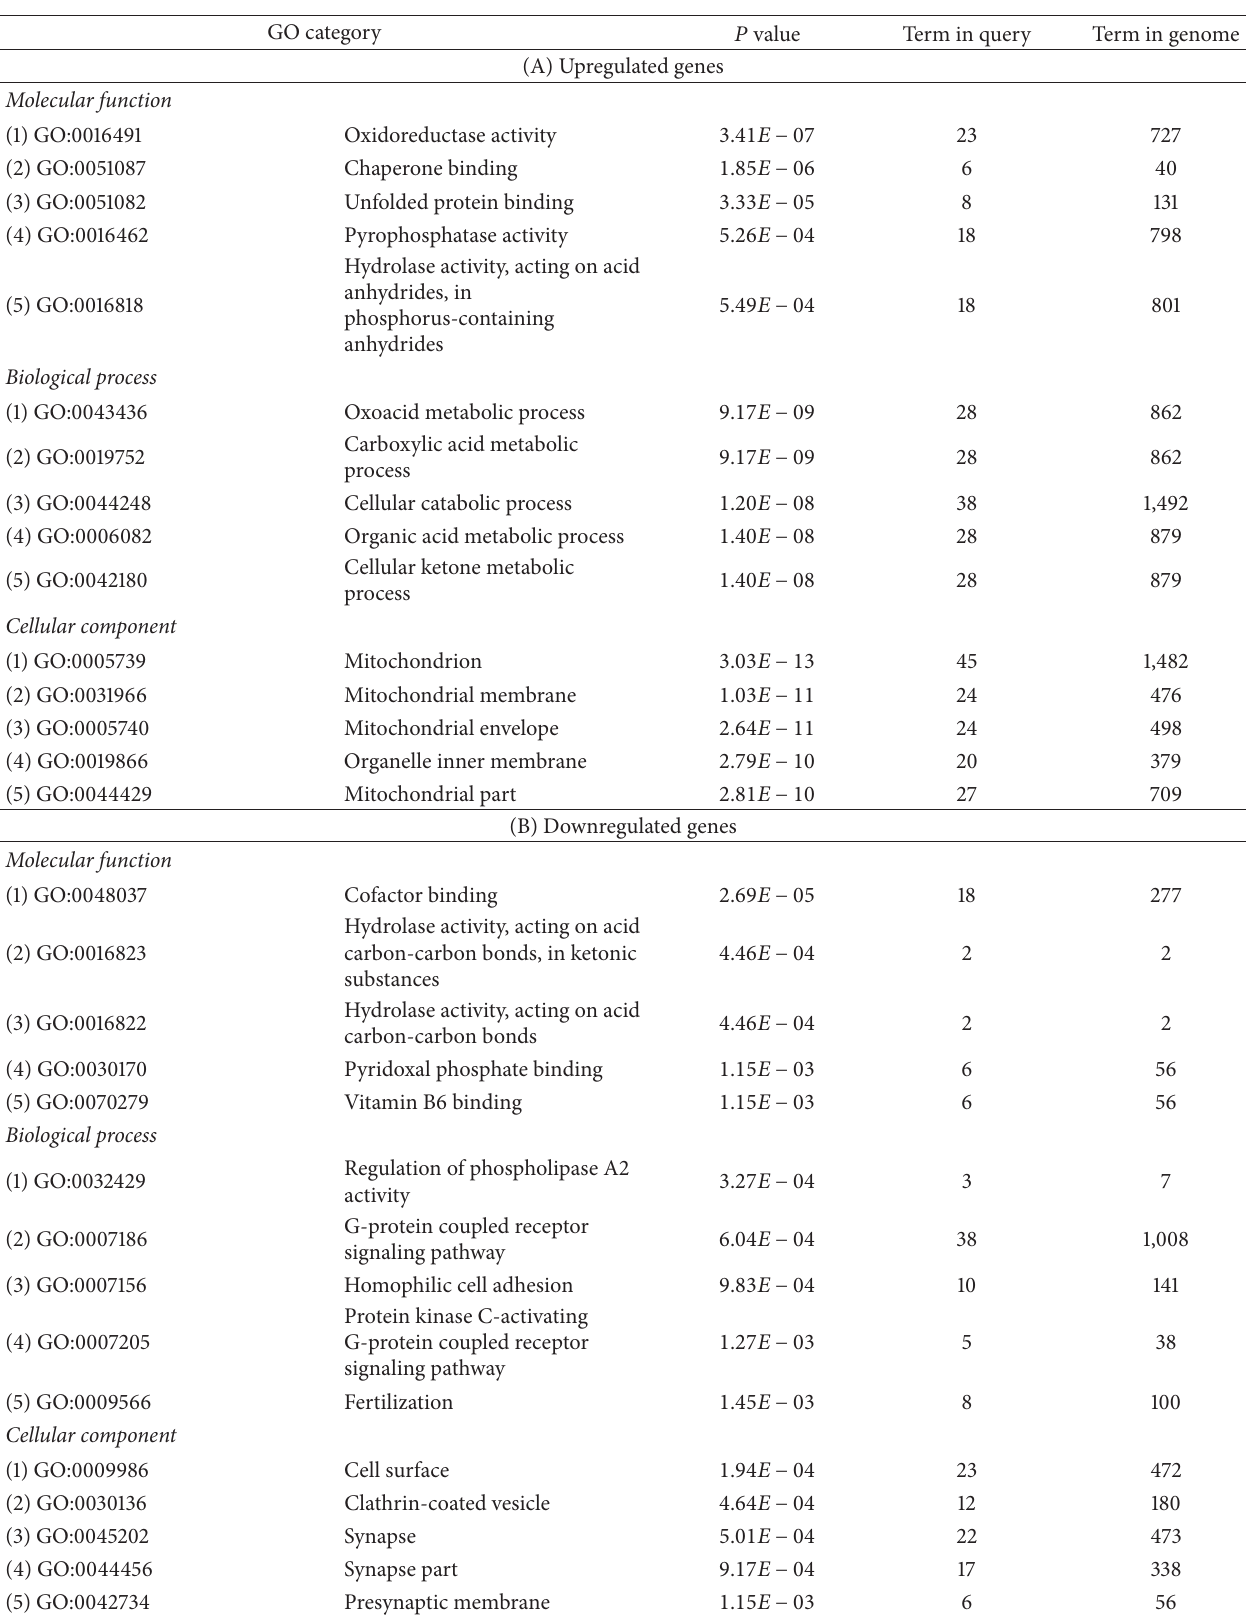
Table 8: Top terms associated with GO functions in the liver of mice fed trans -10, cis -12-CLA using the ToppGene suite application. GO category 𝑃 value Term in query Term in genome (A) Upregulated genes Molecular